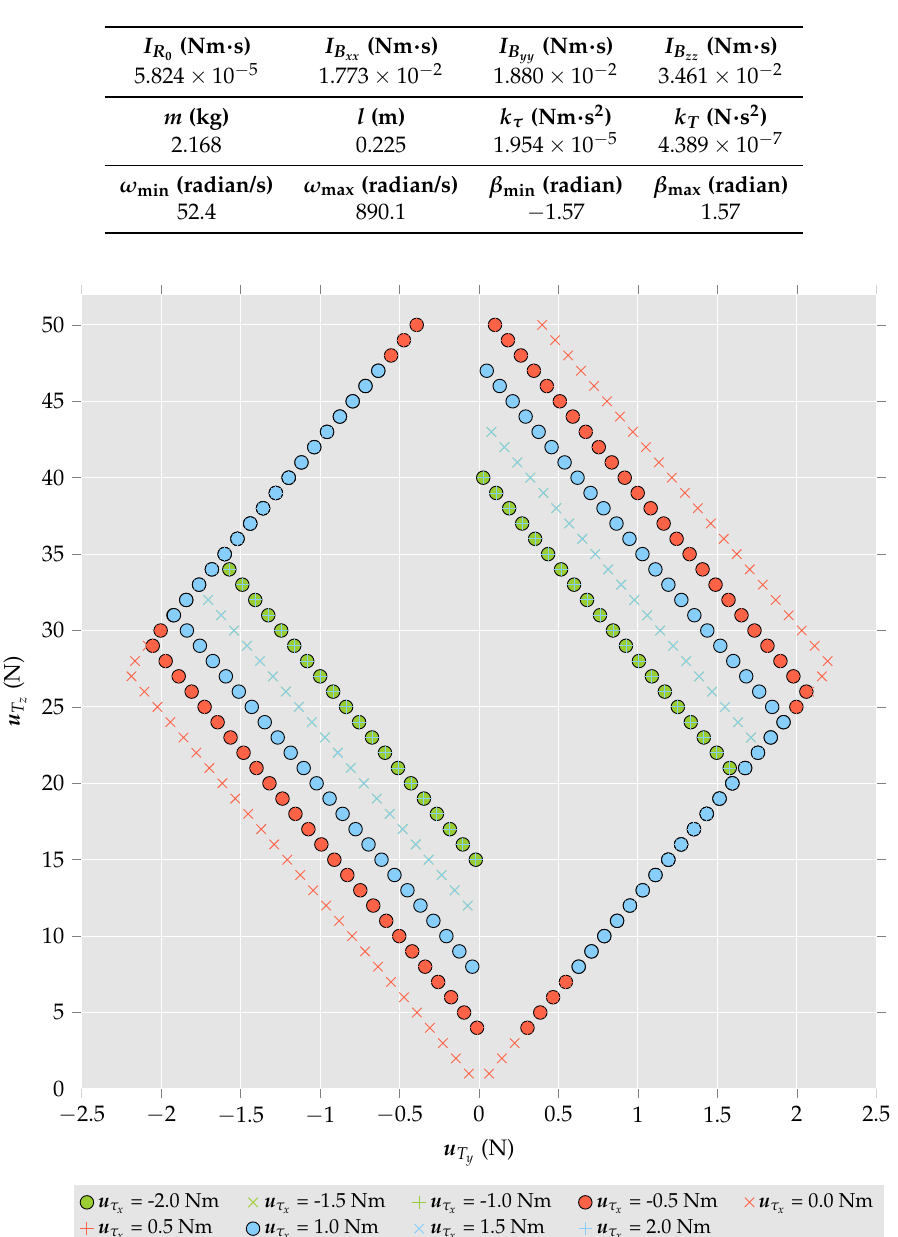
Table 2. Physical parameters for the single tilt-rotor multirotor helicopter.